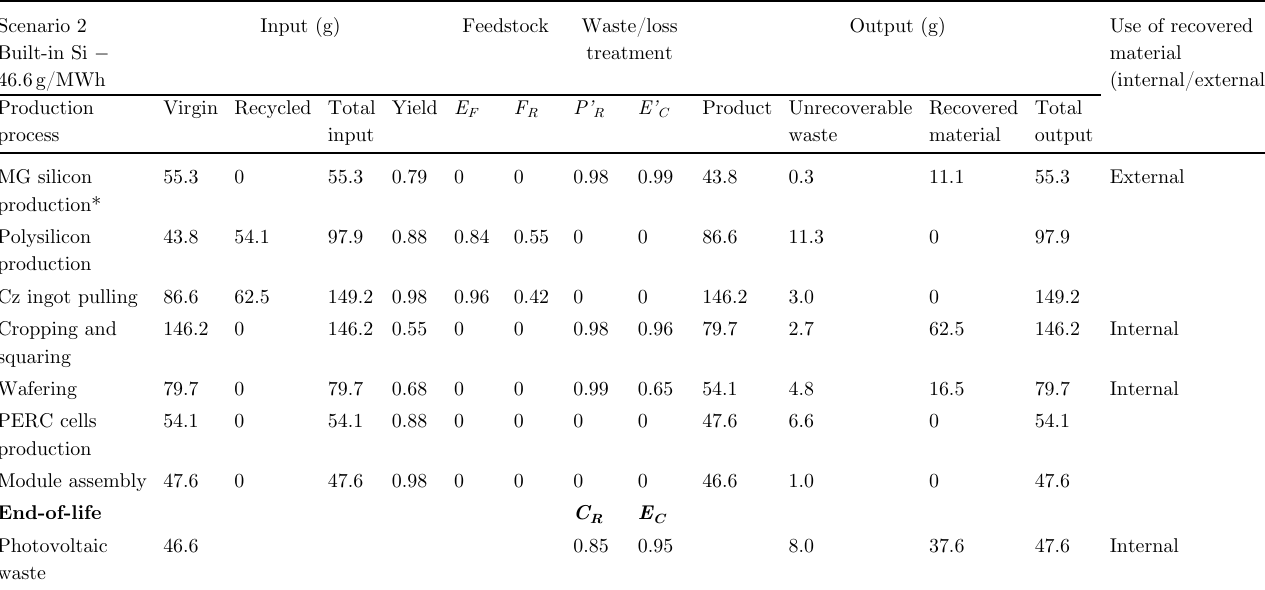
* The mass of material entering MG silicon production is transformed to mass of silicon in quartzite (SiO around 46.75% weight in quartzite [45].